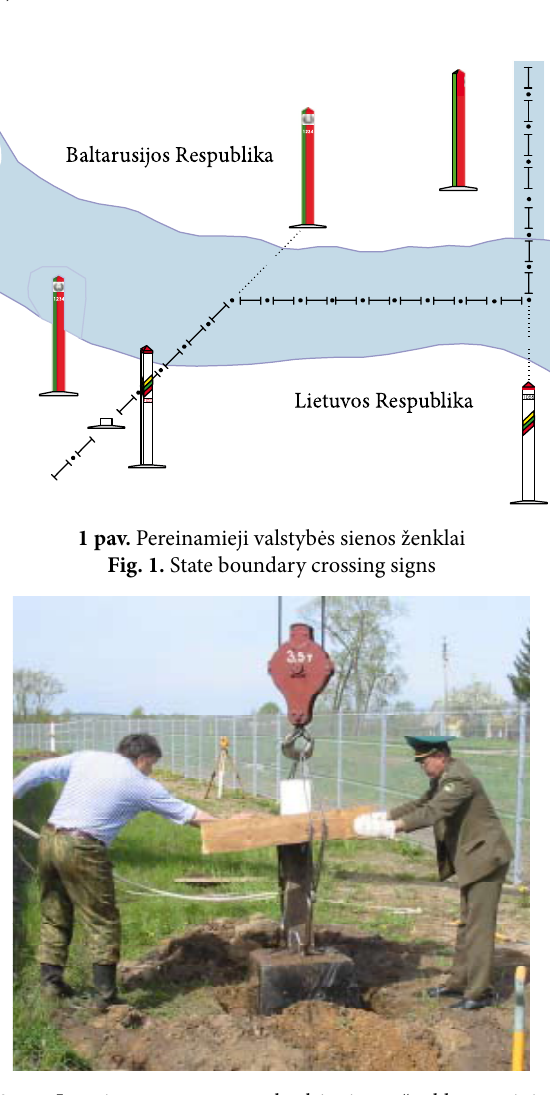
Fig. 2. Installation of the central (poligonometric) state boundary post